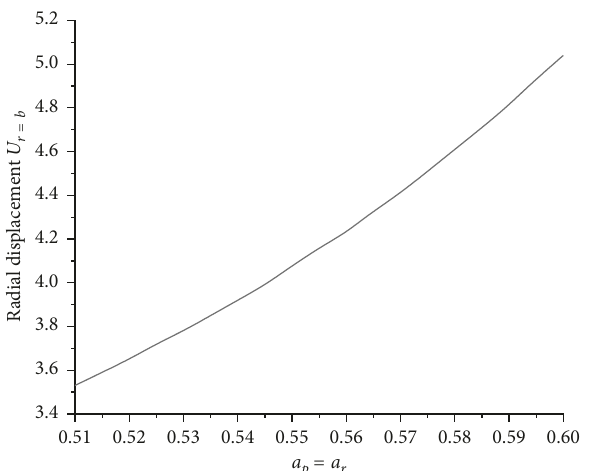
Figure 16: Variation of radial displacement on the opening surface with different values of a .